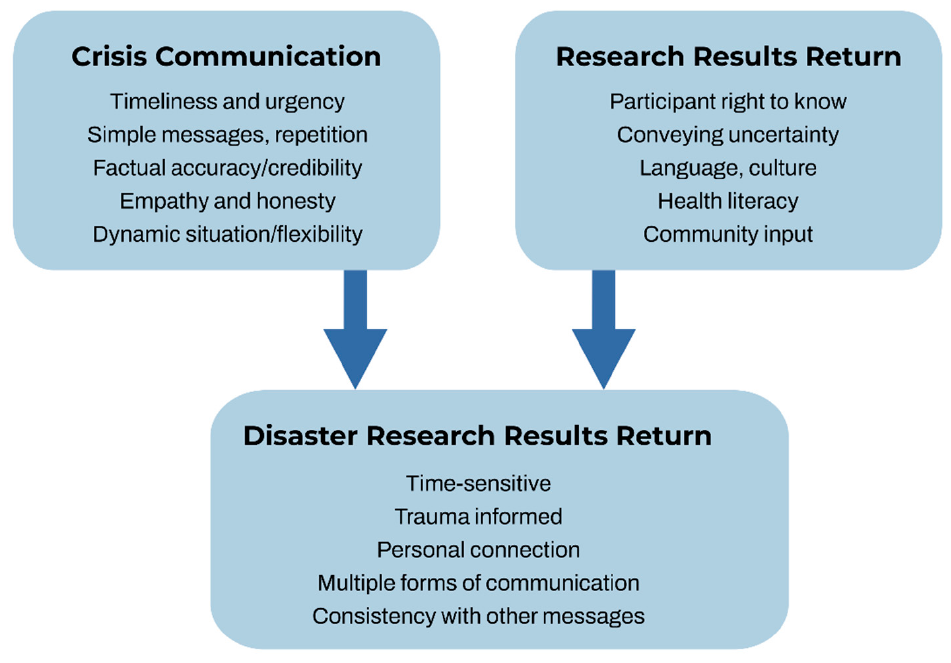
Figure 3. Framework for returning individual results to participants after a disaster adapted from Lebow-Skelley, 2020 [19] and CDC, 2002 [25] .